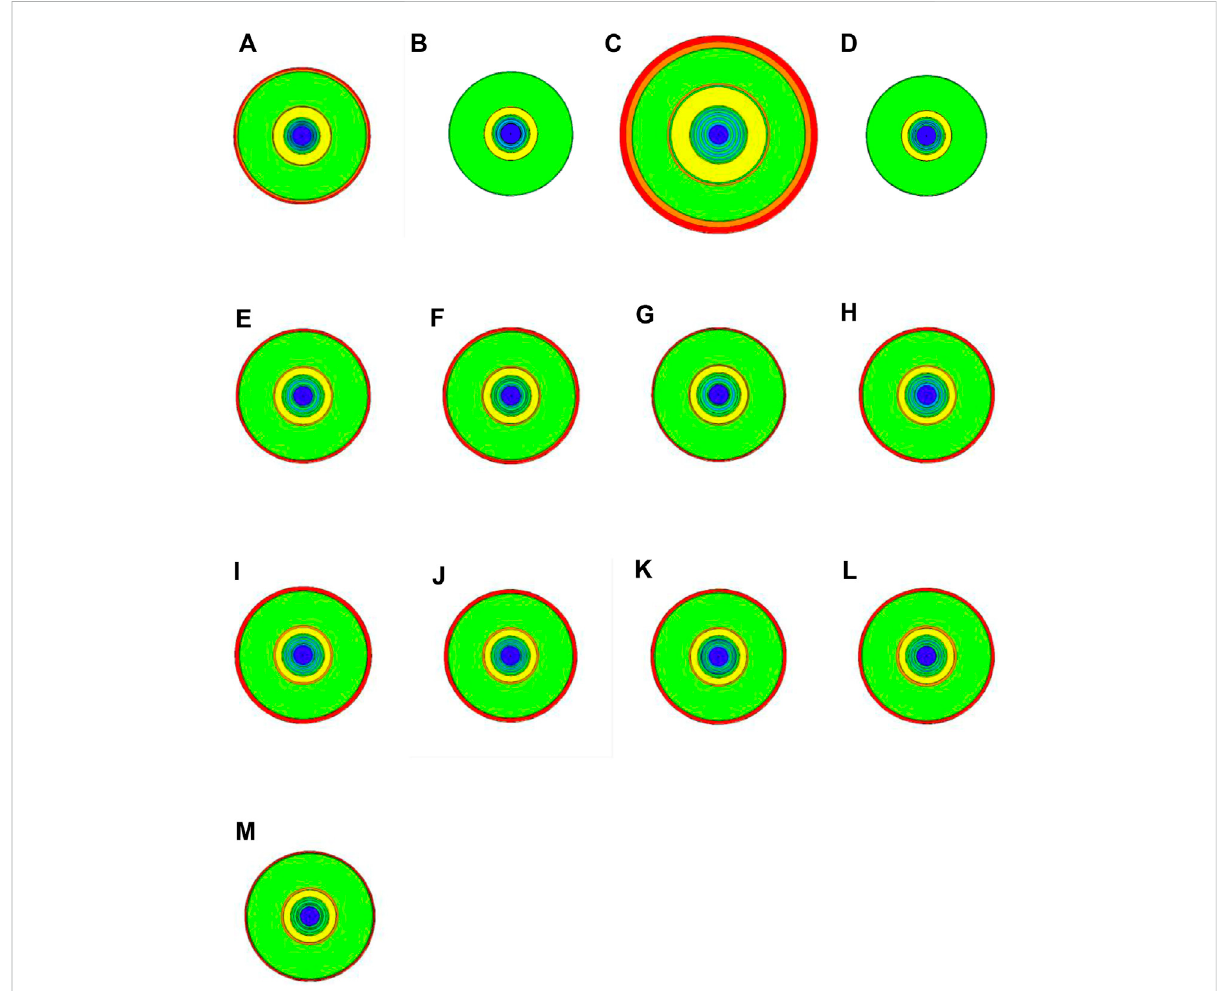
FIGURE 6 Cross-sections of the geometrical structures of the initial design and typical individuals after optimization; (A) initial design; (B) case 1 with the minimal weight; (C) case 1 with the minimal dose; (D) case 1 with the minimal volume; (E) case 1 with the minimal weight within the tolerable limits; (F) case 1 with the minimal dose within the tolerable limits; (G) case 1 with the minimal volume within the tolerable limits; (H) case 2 with minimal weight; (I) case 2 with minimal dose; (J) case 2 withminimal volume; (K) case 3with minimalweight; (L) case 3with minimal dose;and (M) case 3 with minimal